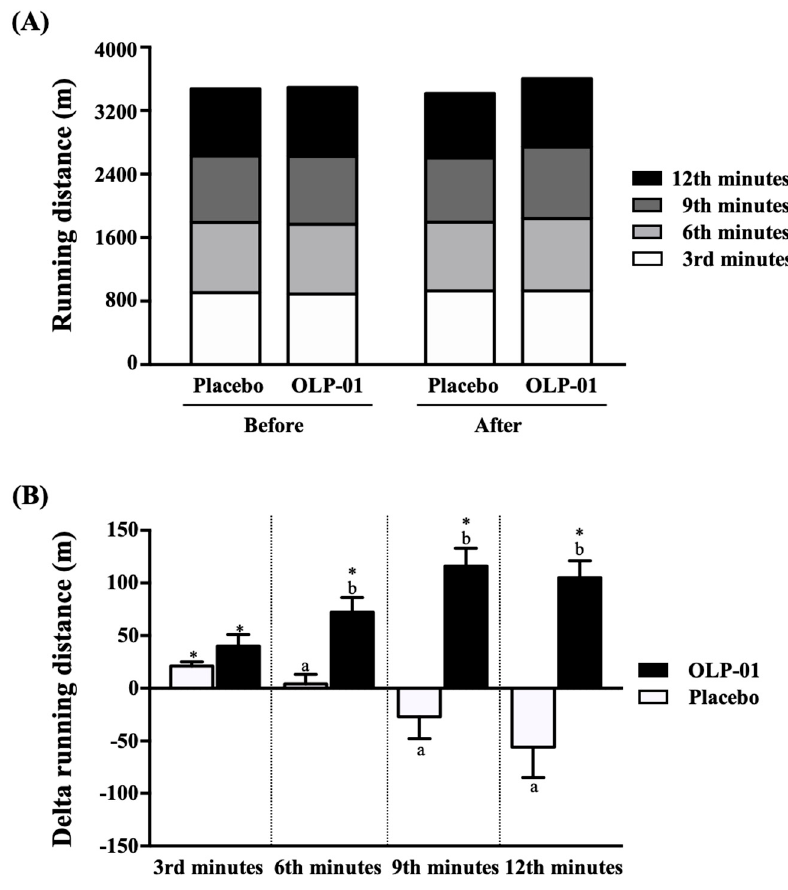
Figure 2. Effects of OLP-01 supplementation combined with three weeks of regular training and two weeks of de-training on ( A ) running distance and ( B ) change in running distance. Data are presented as mean ± SD. Different superscript letters (a, b) indicate significant difference at p < 0.05, and pre- and post-administration effects were statistically analyzed using a paired Student’s t -test, * p < 0.05, at each time point (3rd, 6th, 9th, and 12th min).